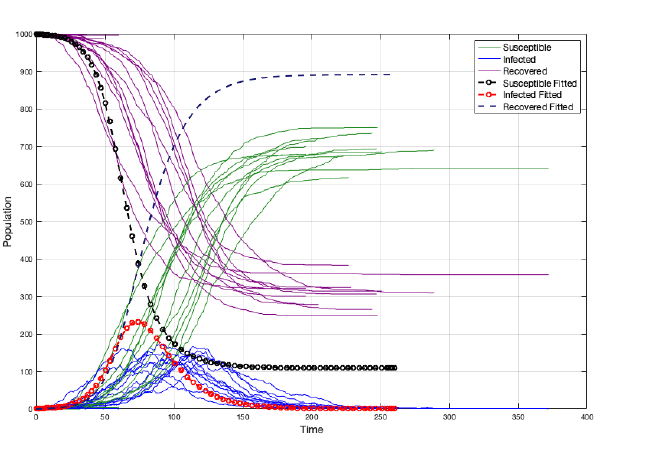
Figure 19. Different fit for w .